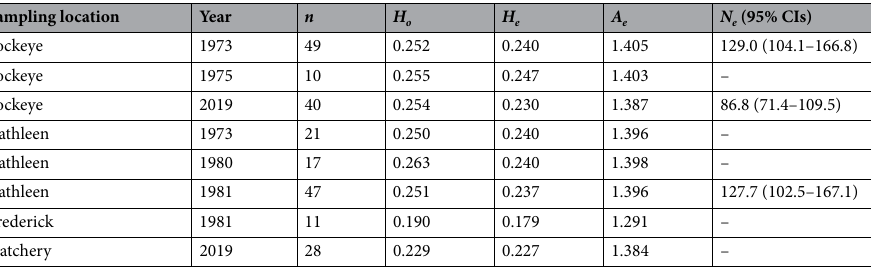
Table 1. Diversity estimates including heterozygosity [observed ( H o ) and expected ( H e )], effective number of alleles ( A e ), and effective population size ( N e ) with 95% confidence intervals (CIs) for individuals in Sockeye Lake, Kathleen Lake, Frederick Lake, and the Whitehorse Rapids Fish Hatchery (neutral, 271 SNPs). Note: N e was not determined when sample size ( n ) was less than